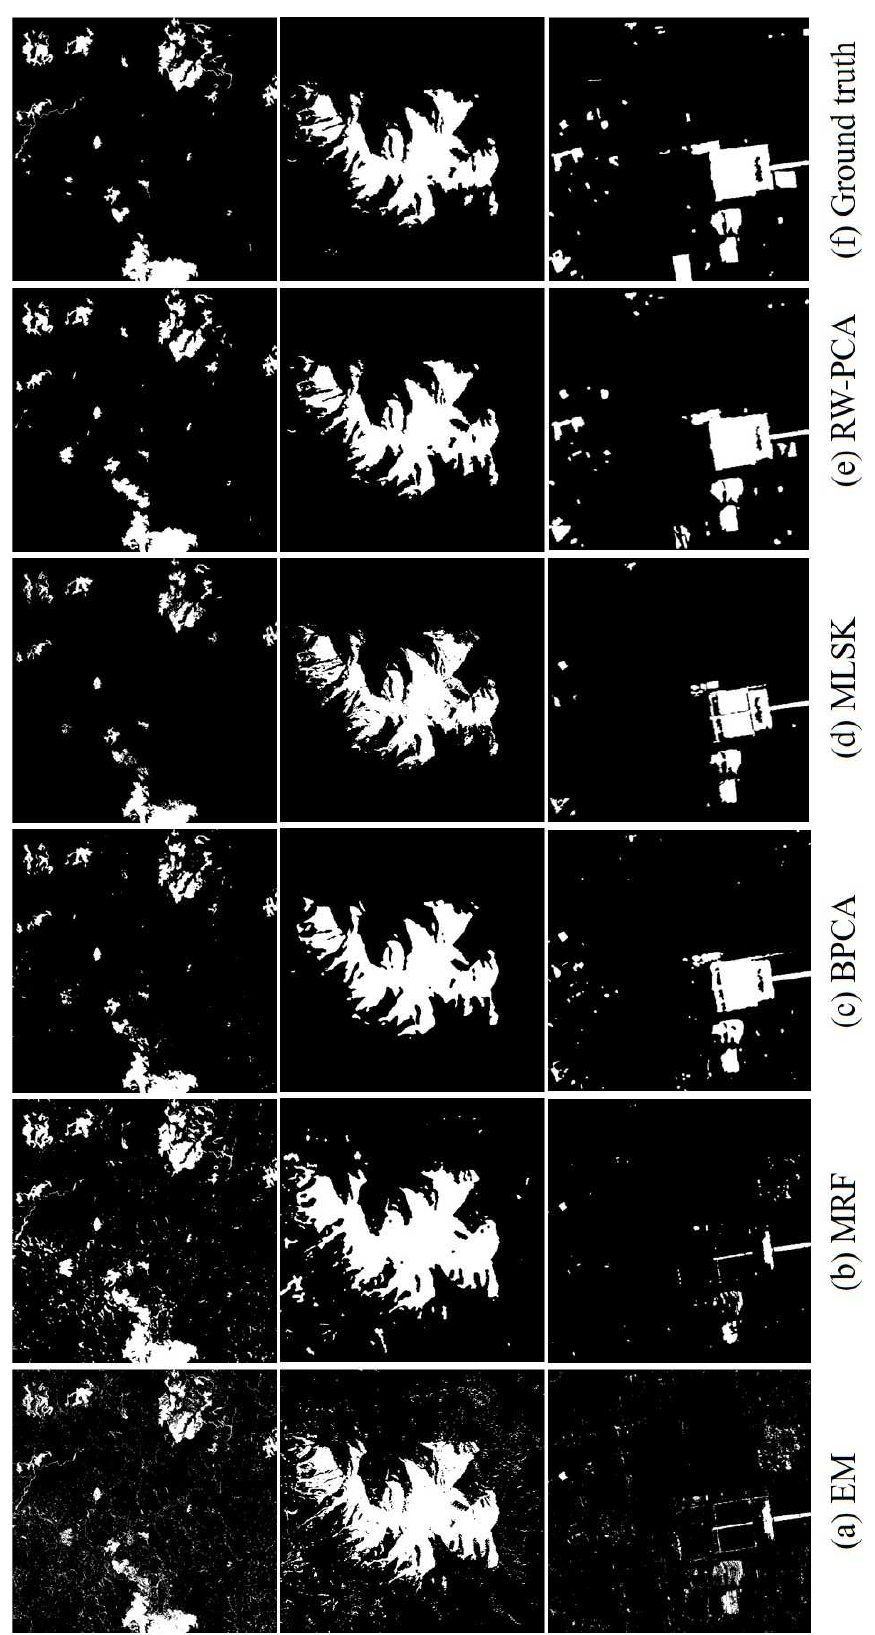
Figure 10. ( a – f ) Change detection results for different approaches on the test data